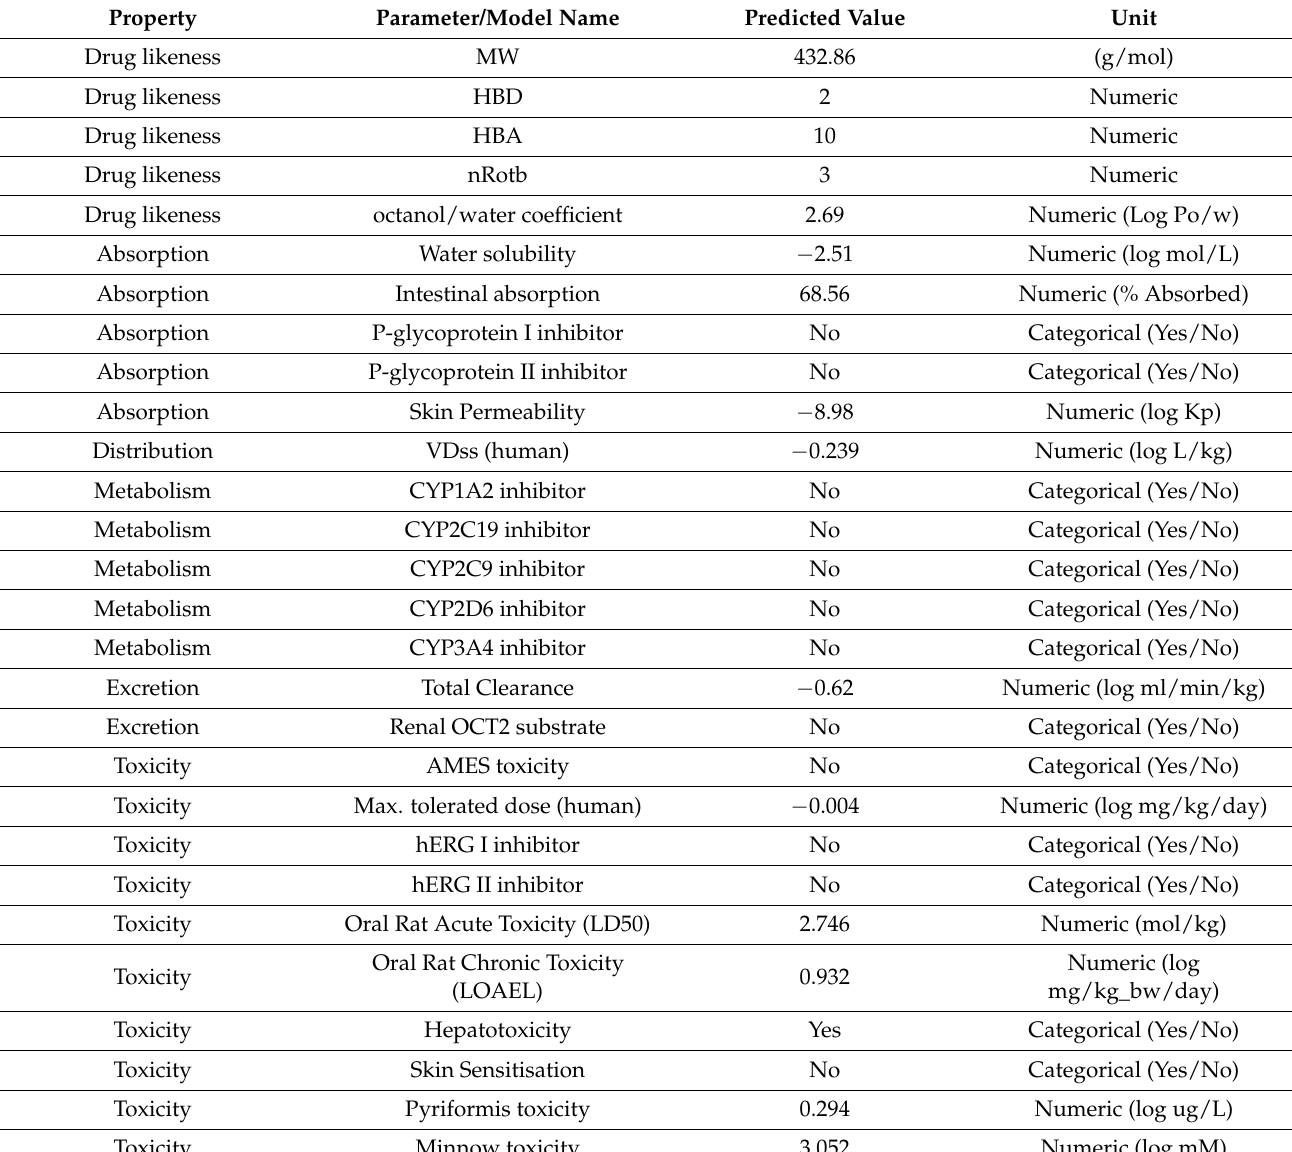
Table 4. The drug likeness profile and ADMET